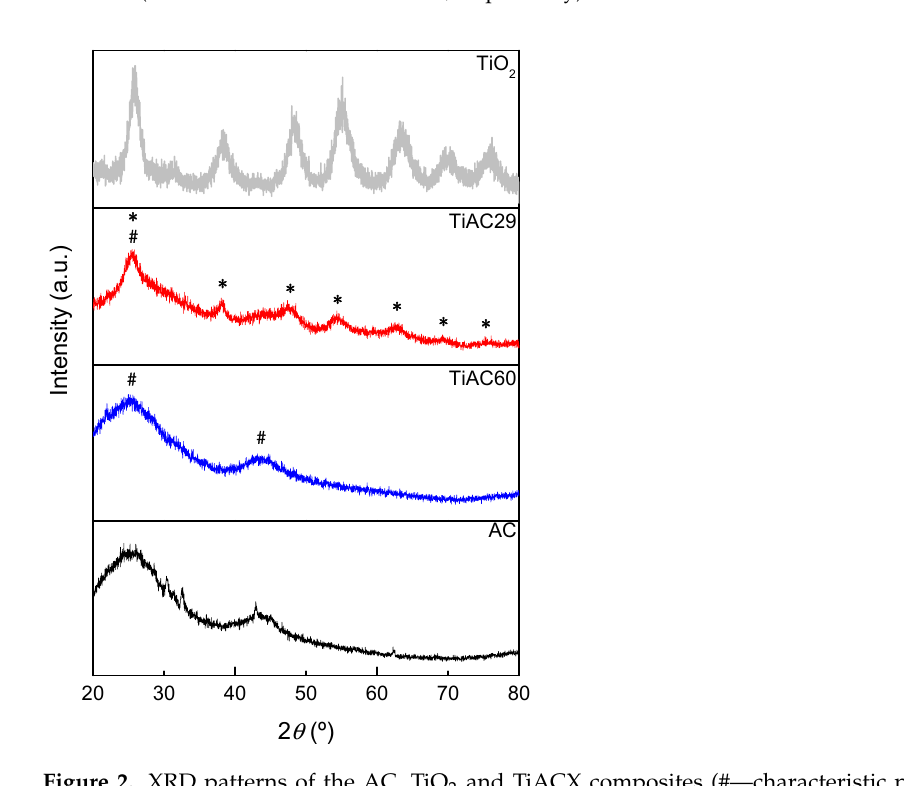
Figure 1. XRD patterns of TiO 2 samples thermally treated under vacuum at different temperatures. Patterns used as standards for pure anatase and brookite samples from Crystallography Open Database (COD ID: 1526931 and 9009087, respectively).